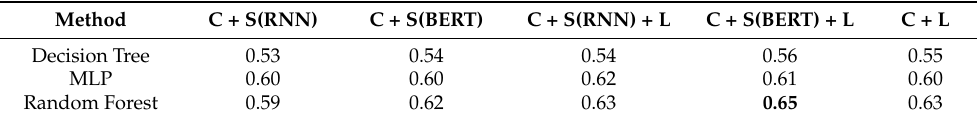
Table 5. F1 scores (positive class) for reply detection on Linux IRC reply dataset. C denotes Conver- sation features, S denotes semantic information while L stands for lexical information. More details about used features can be found in Table 3.